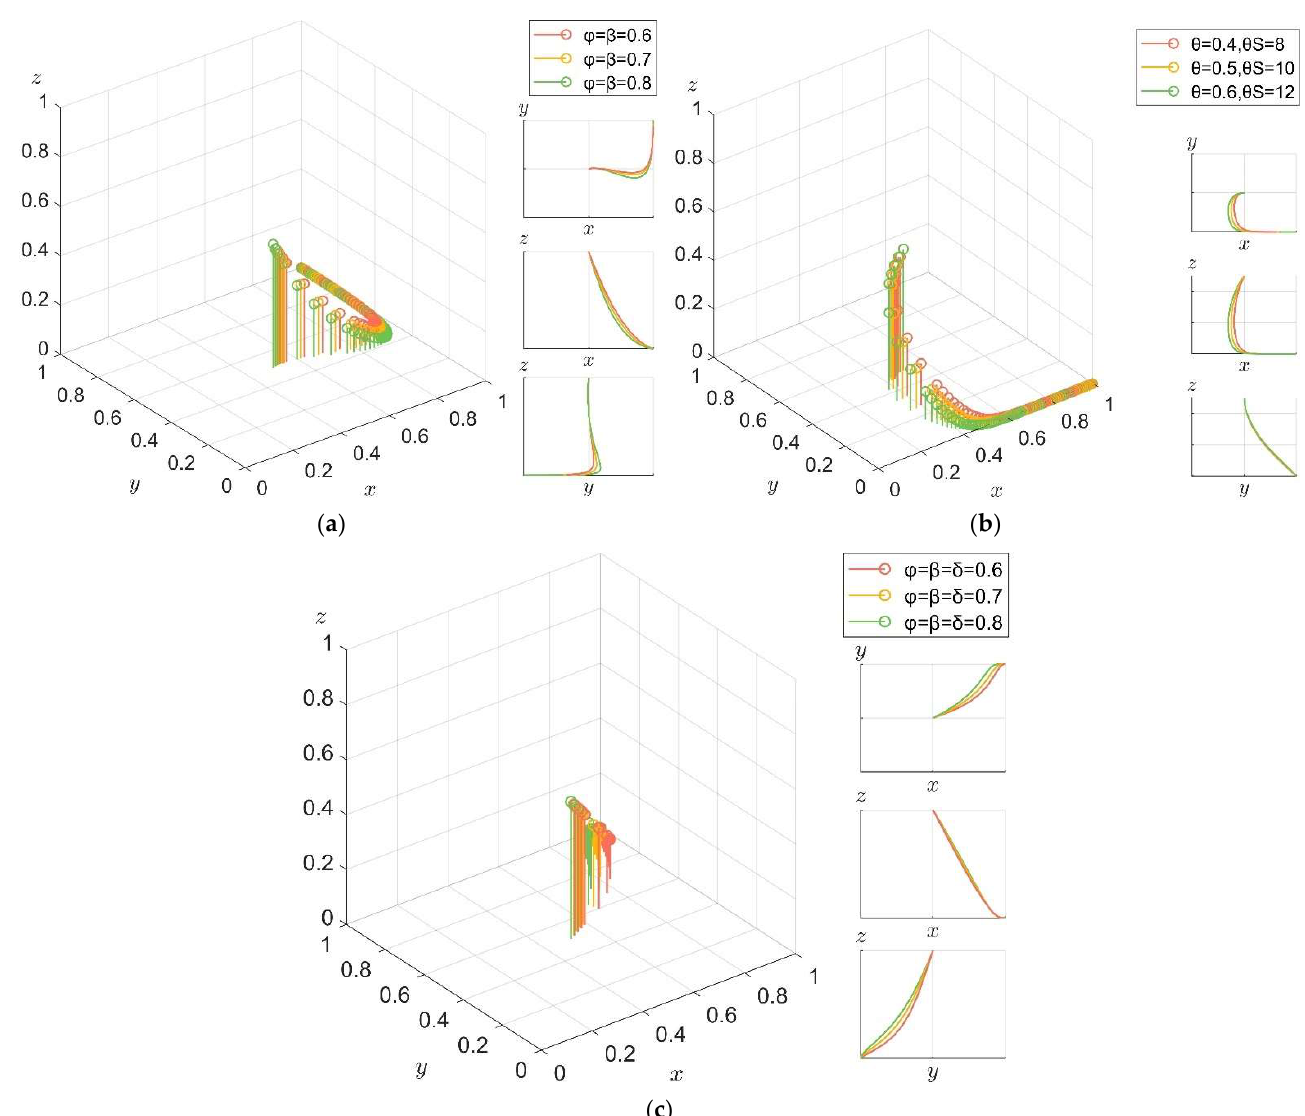
Figure 10. Impact of government guidance and punishment policy on low-carbon technology R&D behavior of enterprise. ( a ) Evolution path of the system under positive guidance policy. ( b ) Evolution path of the system under punishment policy. ( c ) Evolution path of the system under both policies.